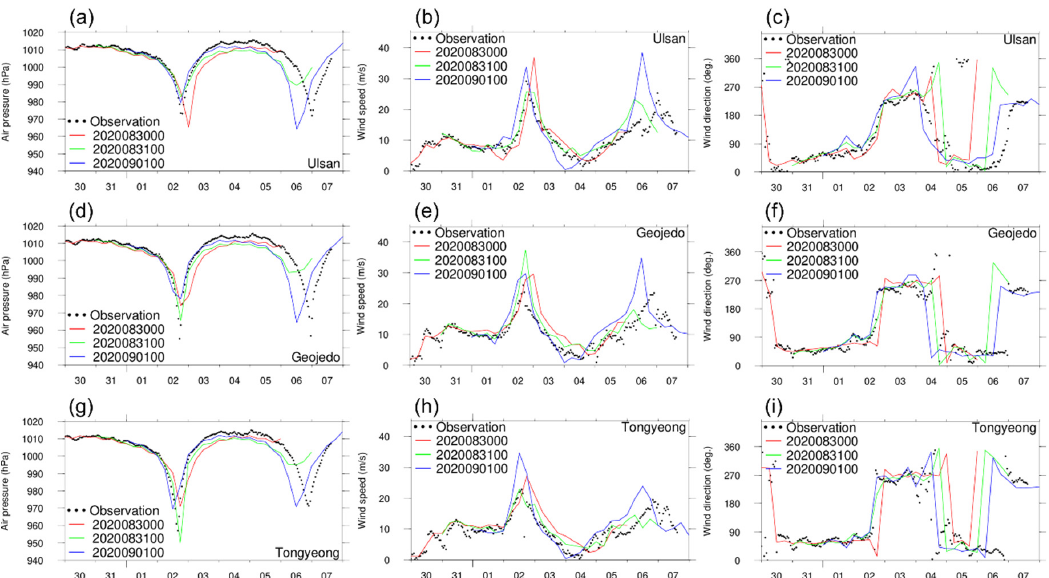
Figure 5. Comparison of the MPAS forecast with the observations (Ulsan, Geojedo, and Tongyeong) for the case of Maysak in 2020. ( a , d , g ) surface pressure (hPa); ( b , e , h ) wind speed (m/s); ( c , f , i ) wind direction (degree). Here, the x -axis indicates the time with the date of the simulation period, and the interval of observation data is one hour.